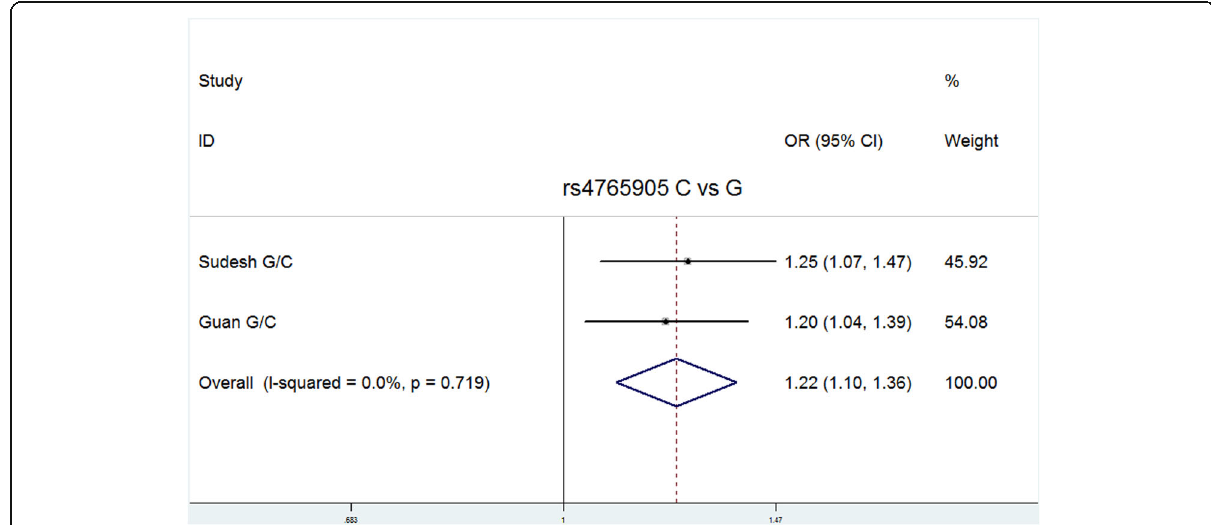
Fig. 9 Forest plot of the allele contrast model (C vs. G) for rs4765905. Significant differences between rs4765905 and the risk of schizophrenia were observed with the allele contrast model (C vs. G) (OR = 1.225, 95% CI = 1.100 – 1.364, P heterogeneity = 0.719, P =